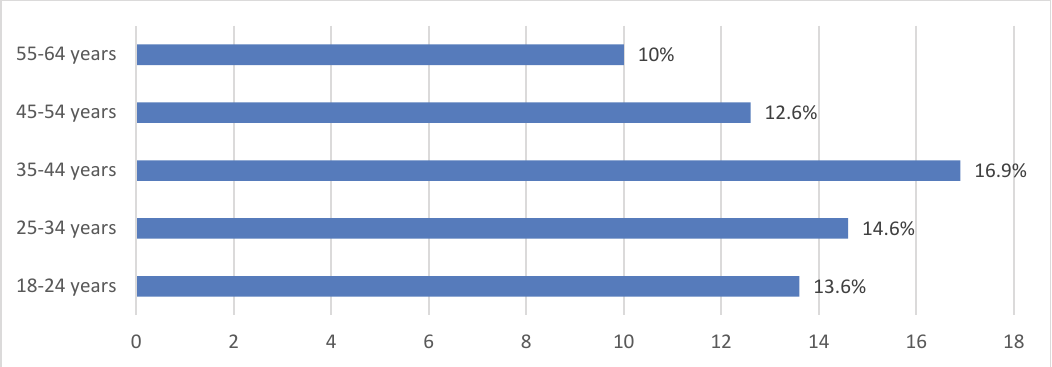
Fig. 1. Early-stage entrepreneur share in Indonesia 2018 Source: Statista, (2019)